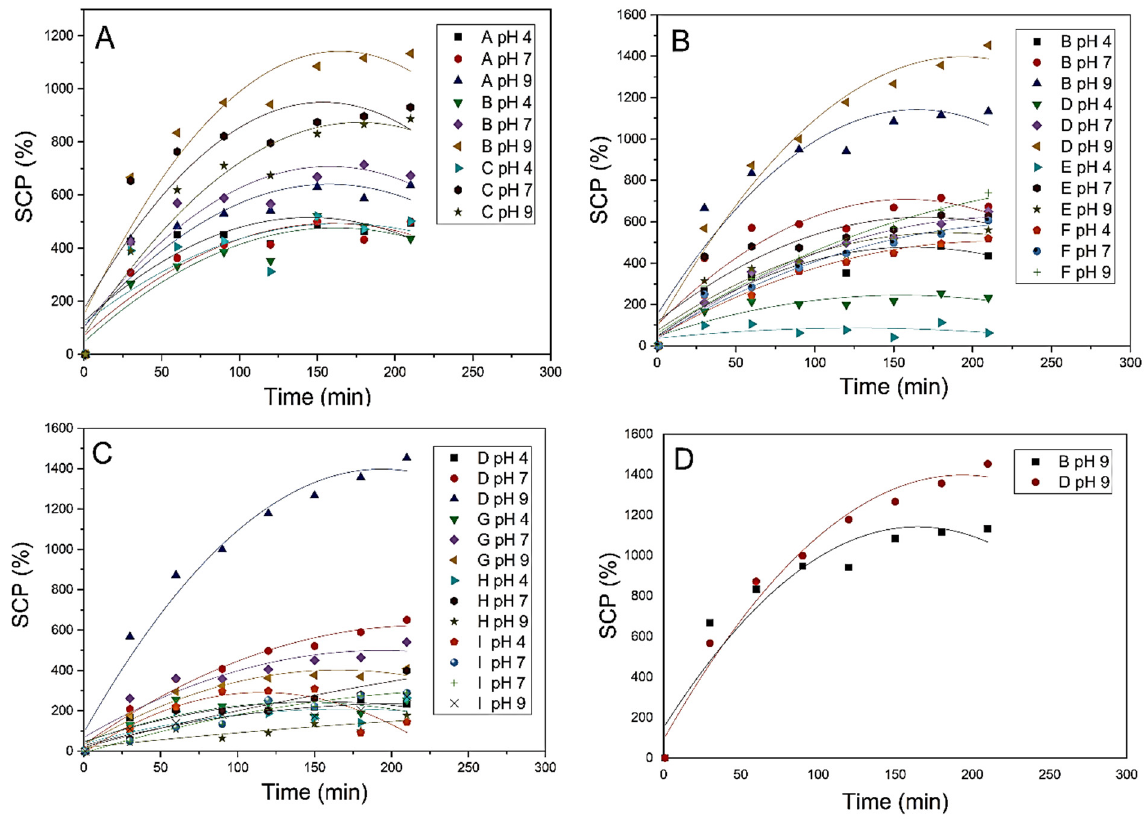
Figure 1. Effect of AA ( A ), OP ( B ) and EGDMA percent on SCP ( C ), and comparison between polymers ( B , D ) exhibiting the highest absorption efficiency ( D ).